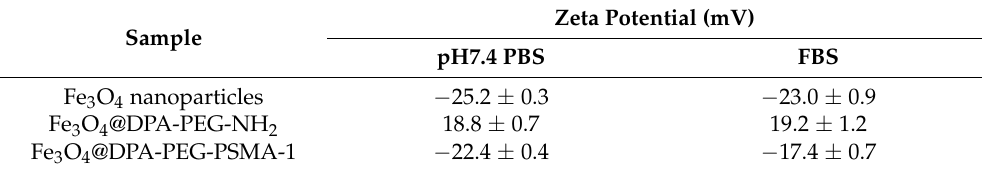
Table 1. Zeta potential of SPIONs.